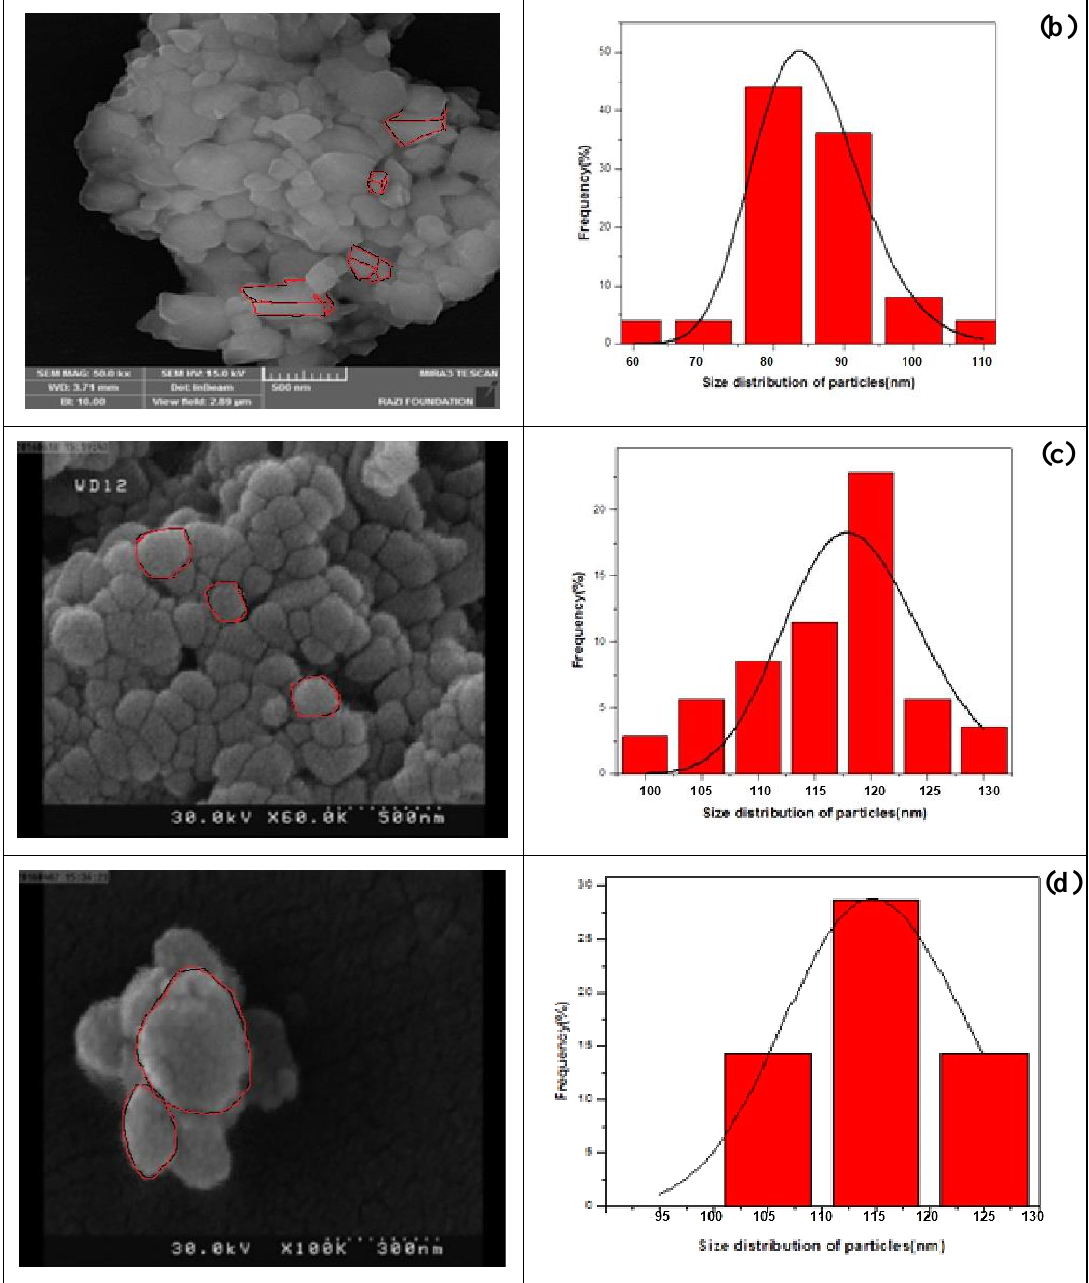
Figure 3. FE-SEM images of KTP nanoparticles synthesized (a) without capping agent and with PVA as capping agent with mole ratio, (b)1:1, (c) 1:2, (d) 1:3, accompanied by size distributions curve of obtained samples with different mole